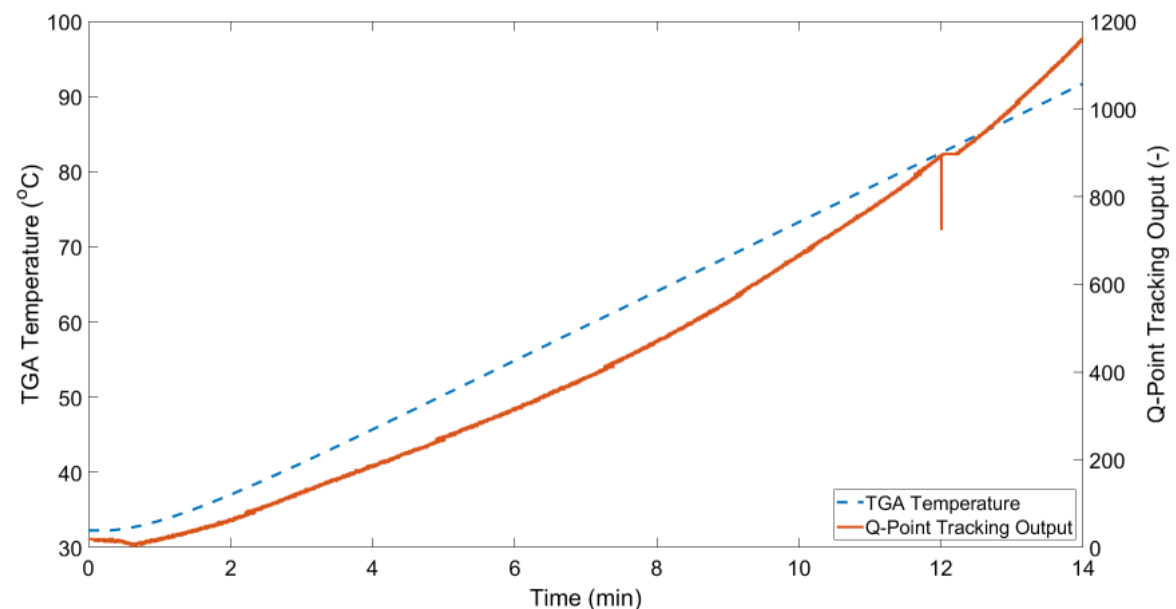
Figure 13. Change of intensity at 1541 nm in the reference all-glass UHRTS interference pattern.